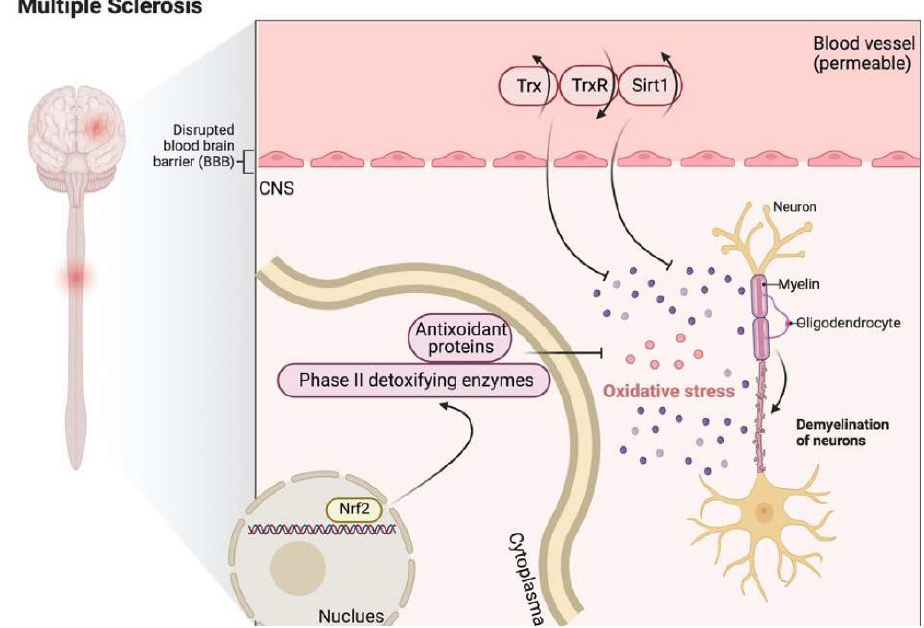
Figure 6. The role of Trx in the pathophysiology of multiple sclerosis (MS). In MS, Trx and sirt1 were upregulated, and TrxR was downregulated. Meanwhile, the activation of the Nrf2 pathway might play a protecting role against oxidative stress by upregulating the expression levels of GSH and Trx. Trx: thioredoxin; TrxR: thioredoxin reductase; Sirt1: sirtuin 1; Nrf2: Nuclear factor (erythroid-derived 2)-like 2.